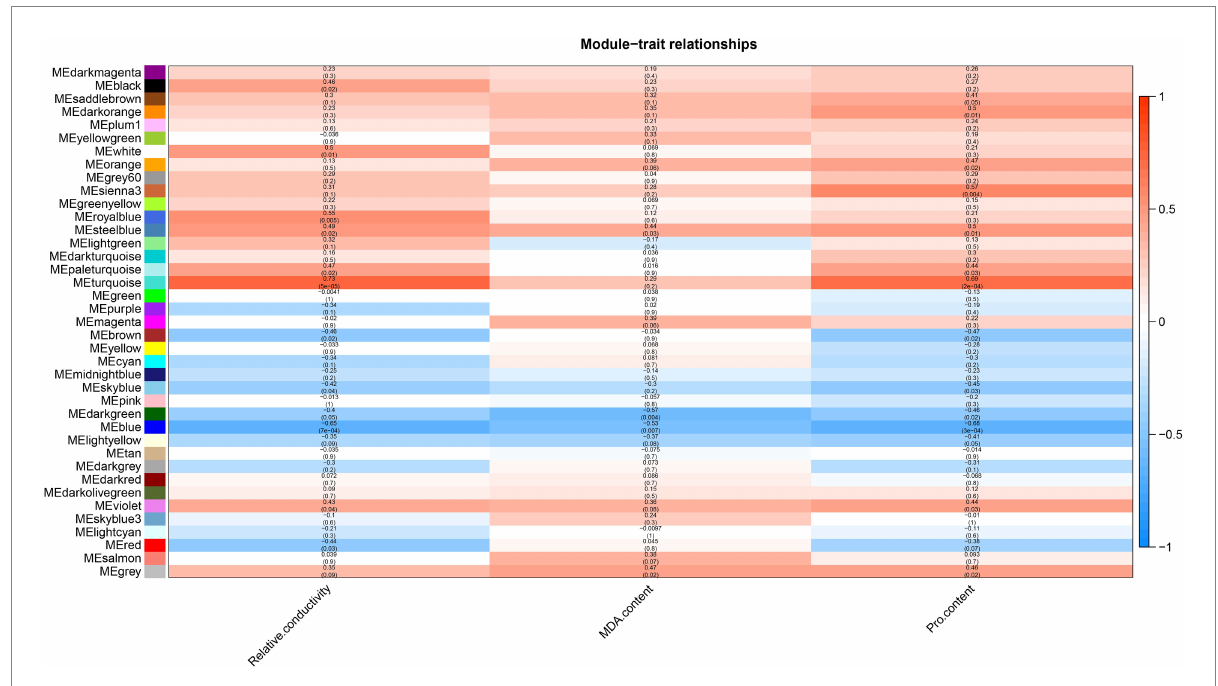
FIGURE 6 Heat map of the correlation between modules and